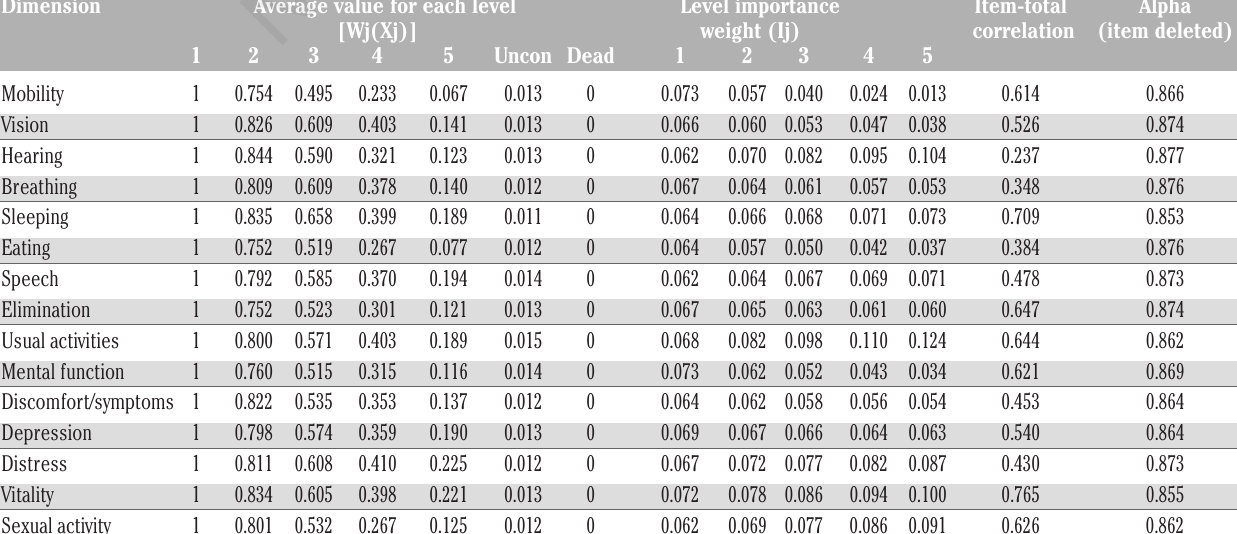
Table 3. Average values and level importance weights for each 15D dimension and internal consistency